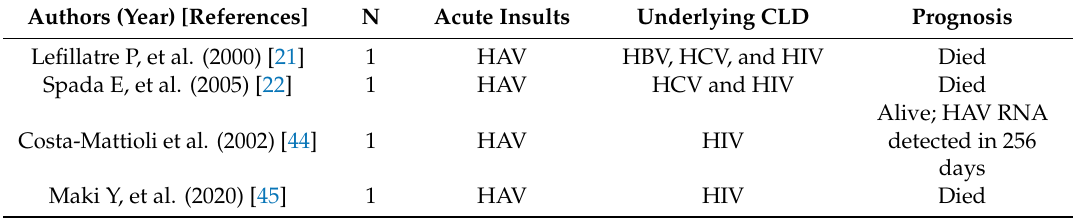
Table 2. Coinfection with hepatitis A virus (HAV) and human immunodeficiency virus (HIV).